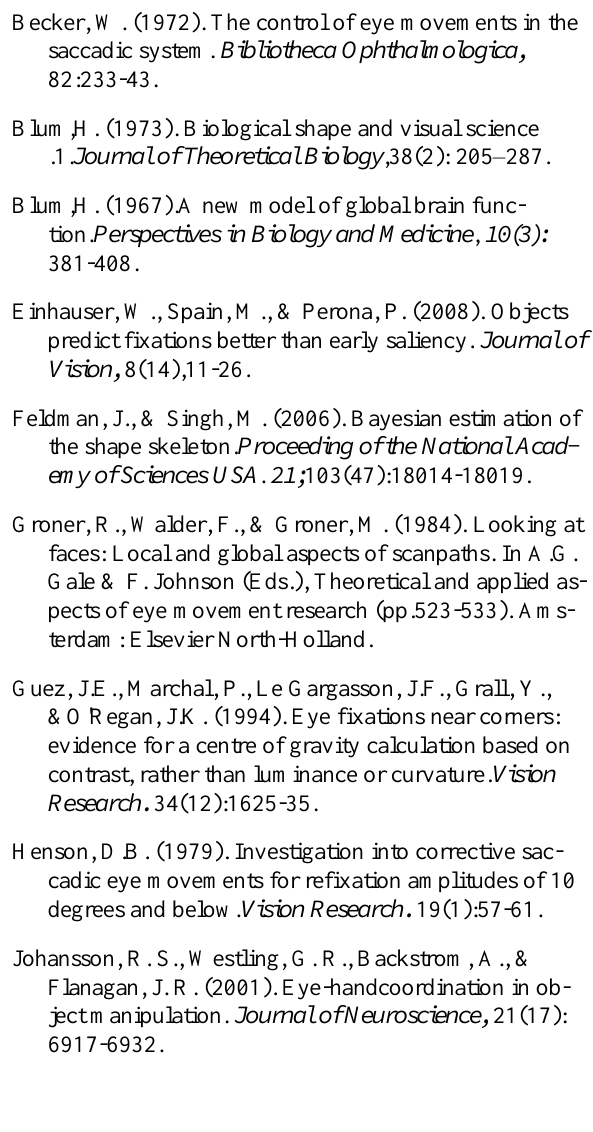
Evidence for a Structural Analysis of Target Selection in Picture